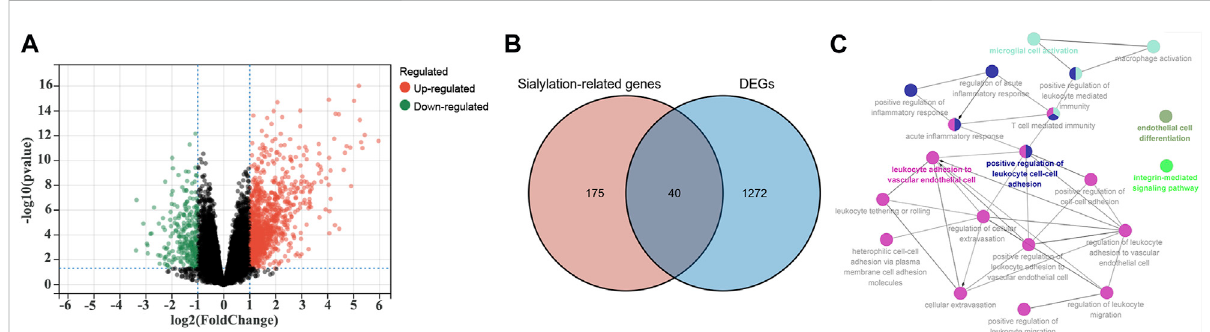
FIGURE 1 Identi fi cation of Sialylation-related DEGs in GSE16879 cohort. (A) A volcano plot of DEGs between CD and normal samples. (B) Intersection of DEGs and Sialylation-related genes. (C) Biological functions of Sialylation-related DEGs. Each color represents a different functional group. Each node represents a GO term and each line represents a correlation between different